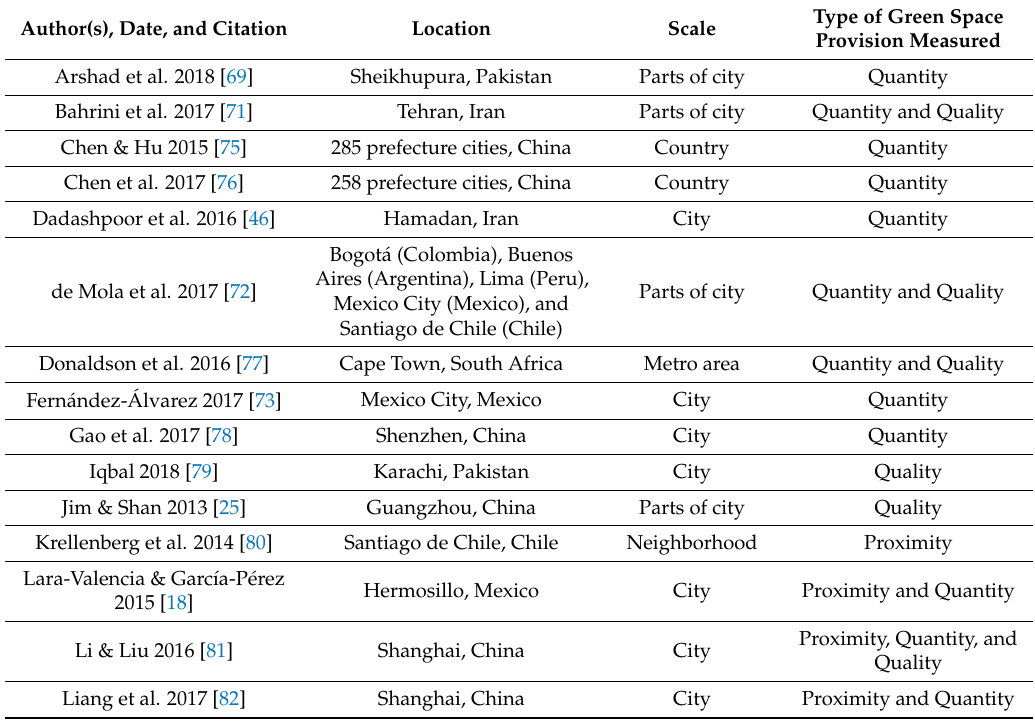
Table 1. Articles included in the